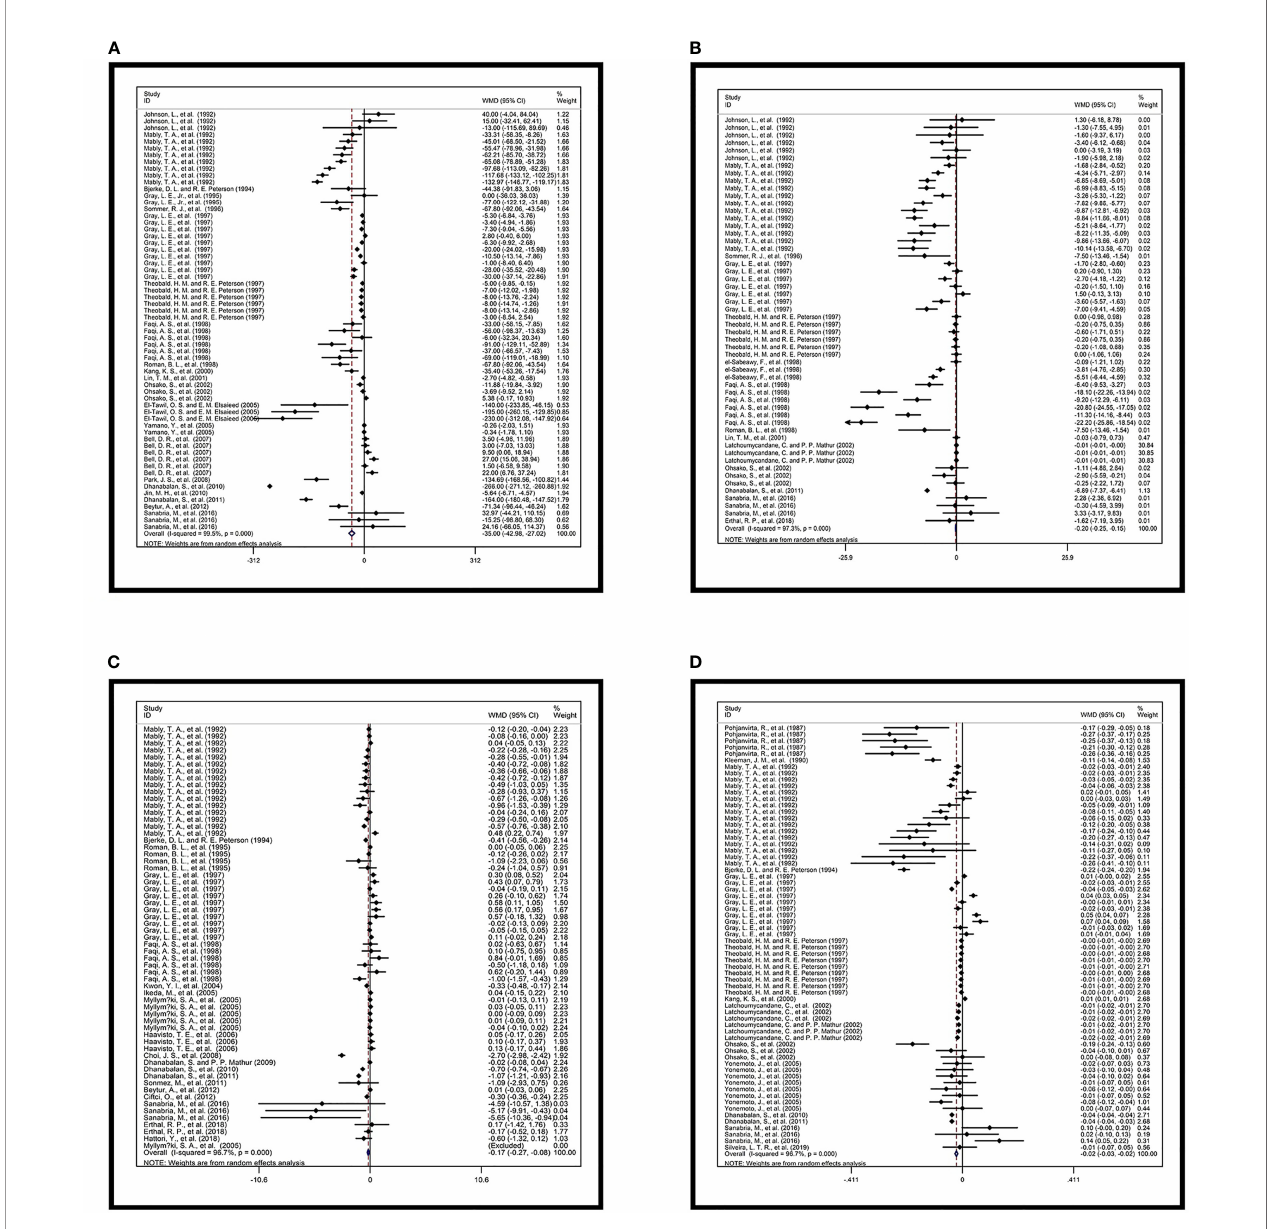
FIGURE 2 | Forest plots of overall effects. Overall effects of TCDD and (A) sperm count (×10 ⁶ ), (B) daily sperm production (×10 ⁶ ), and (C) serum testosterone (ng/ml); (D) Total effect of TCDD and ventral prostate weight